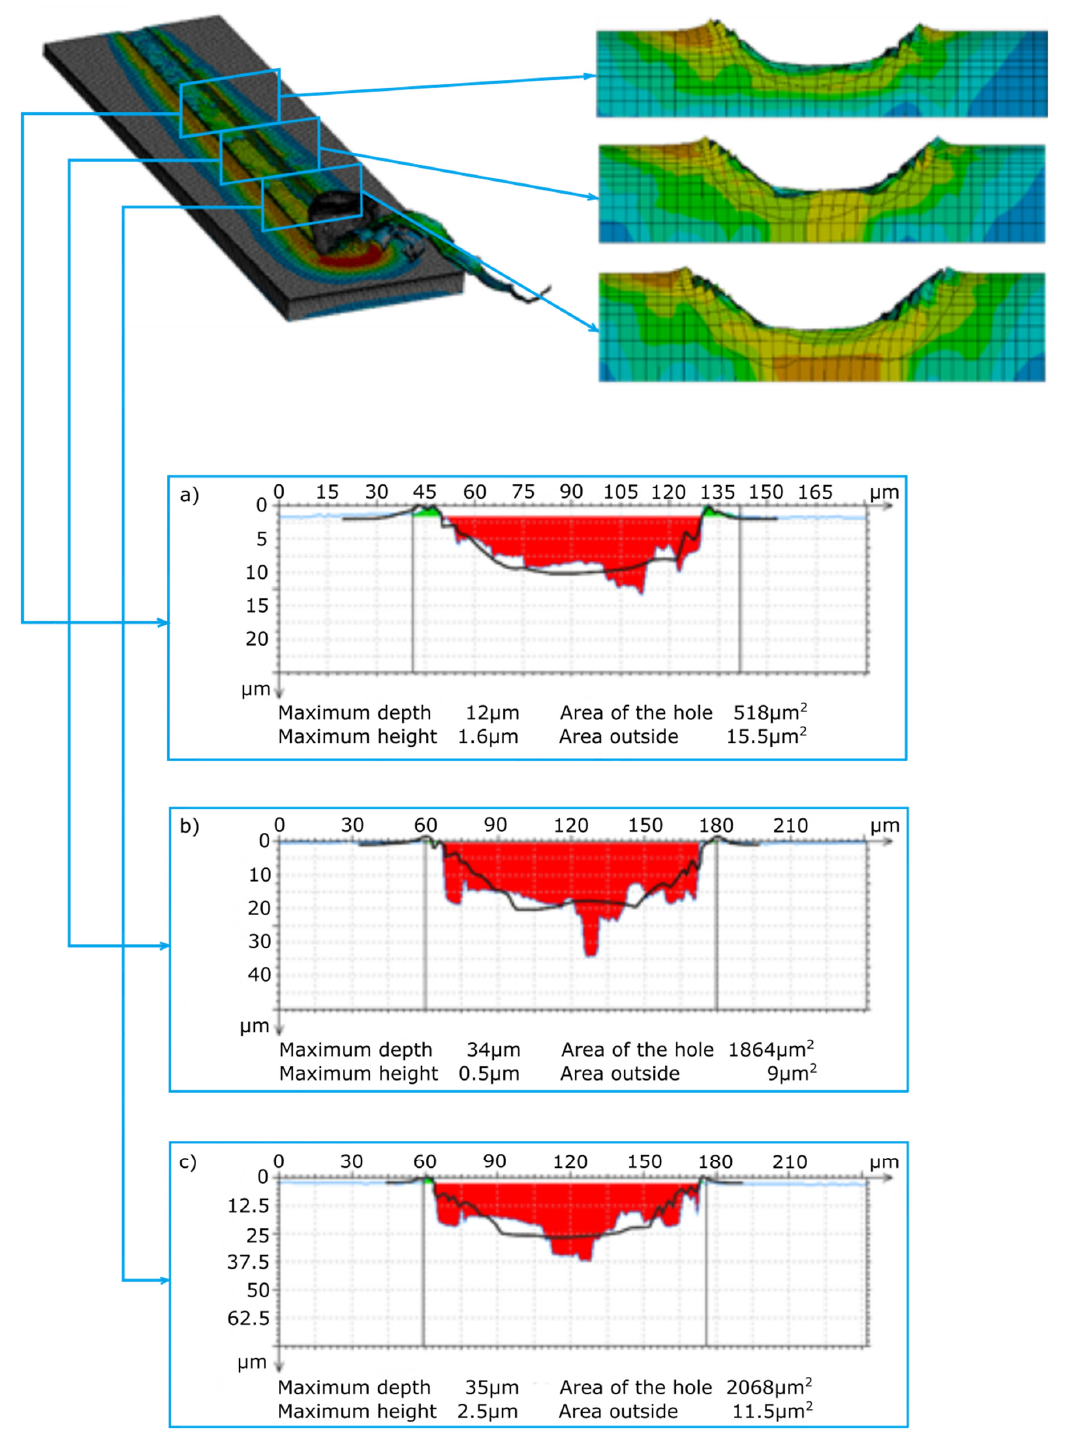
Figure 11. The results of the profiles of the scratch formed in the process of microcutting with the ZS2 grain (simulation tests); ( a ) validation of the scratch profiles in the simulation tests for a depth of cut of 10 µm, ( b ) validation of the scratch profiles in the simulation tests for a depth of cut of 15 µm, and ( c ) validation of the scratch profiles in the simulation tests for a depth of cut of 20 µm.